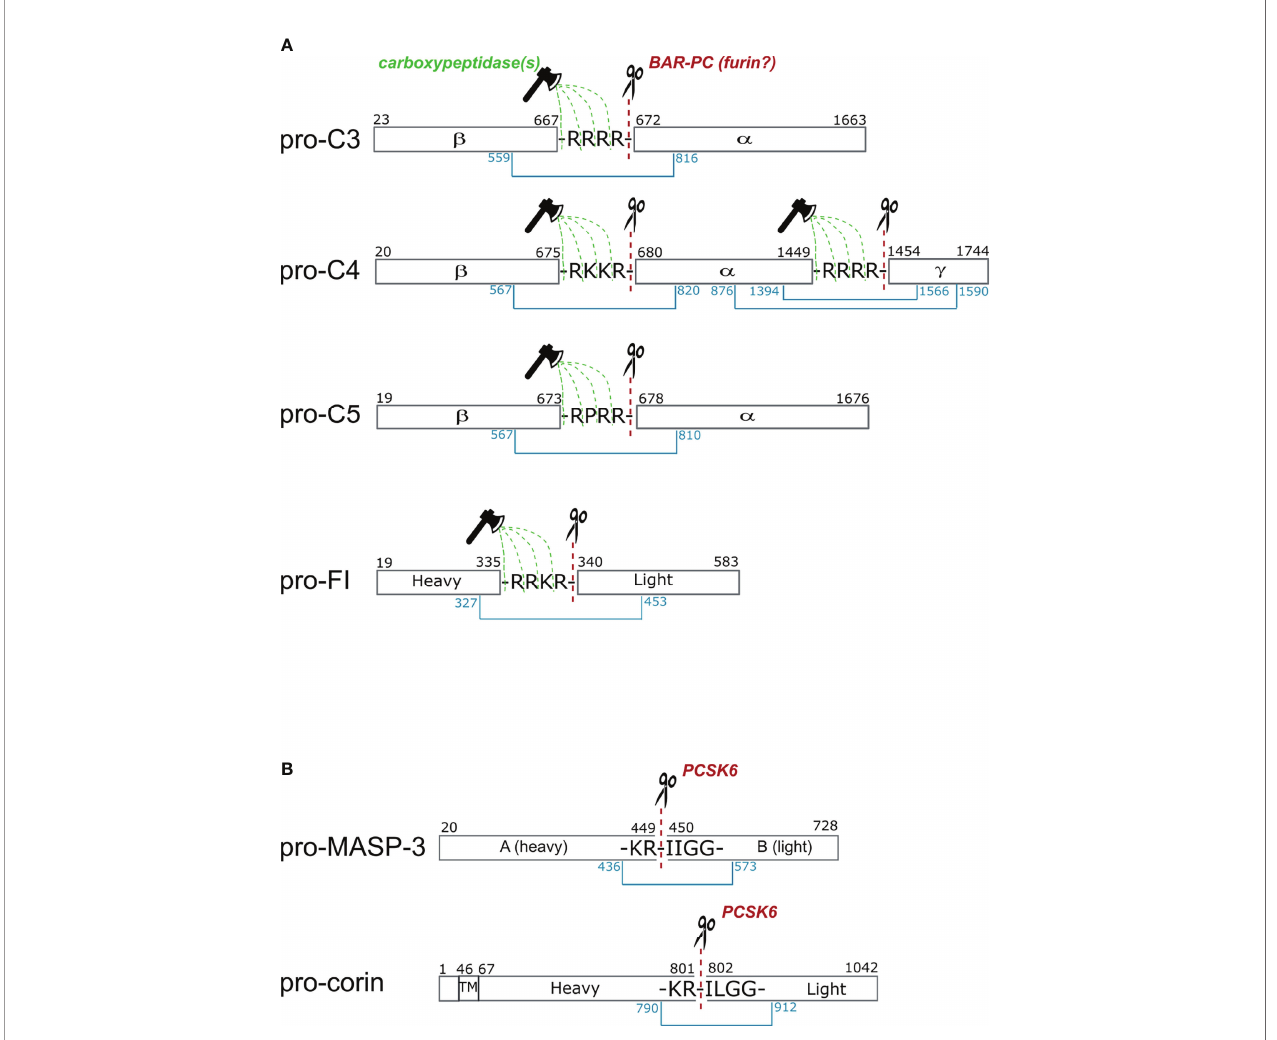
FIGURE 3 | Cleavage sites of proprotein convertases after paired basic residues in C3, C4, C5, factor I, MASP-3 and corin. (A) Complement proteins that are processed intracellularly by proprotein convertases. Cleavage sites of basic amino acid residue-speci fi c proprotein convertases (BAR-PC) are indicated as red dashed lines and scissors. Residual amino acids are trimmed off by carboxypeptidases marked with green dashed lines and ax. After BAR-PC cleavage, the complement proteins disintegrate into multiple chains: a and b chains in C3 and C5, a , b and g chains in C4 and; heavy and light chains in the case of FI. The light chain of FI represents the serine protease domain in the active enzyme. Chains are held together by disul fi de bonds indicated with blue lines. Black numbers show the fi rst and last amino acids of each chain, while blue numbers stand for cysteines that form interchain disul fi de bonds. (B) These two proteins are processed extracellularly by proprotein convertases. The sequences are very similar near the cleavage sites in MASP-3 and corin. The cleavage sites in the propeptide segment performed by PCSK6 are illustrated with red dashed lines and scissors. The with disul fi de bonds connecting the heavy and light chains are indicated with blue lines. In corin the transmembrane (TM) region is also shown, while the activation takes place in the extracellular part of the